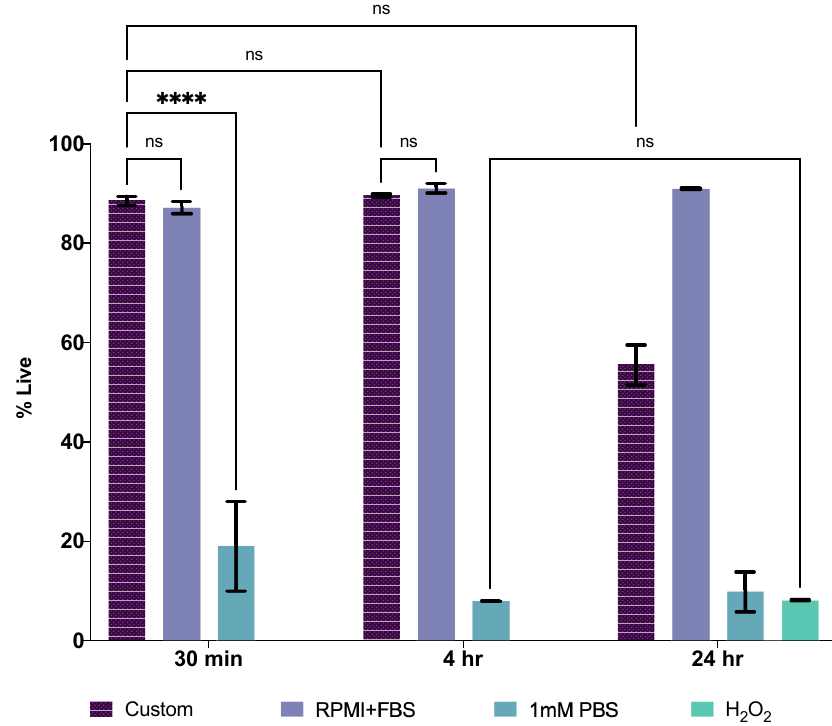
Figure 3. Time course flow cytometry viability analysis of Jurkat cells in RPMI + FBS (live,